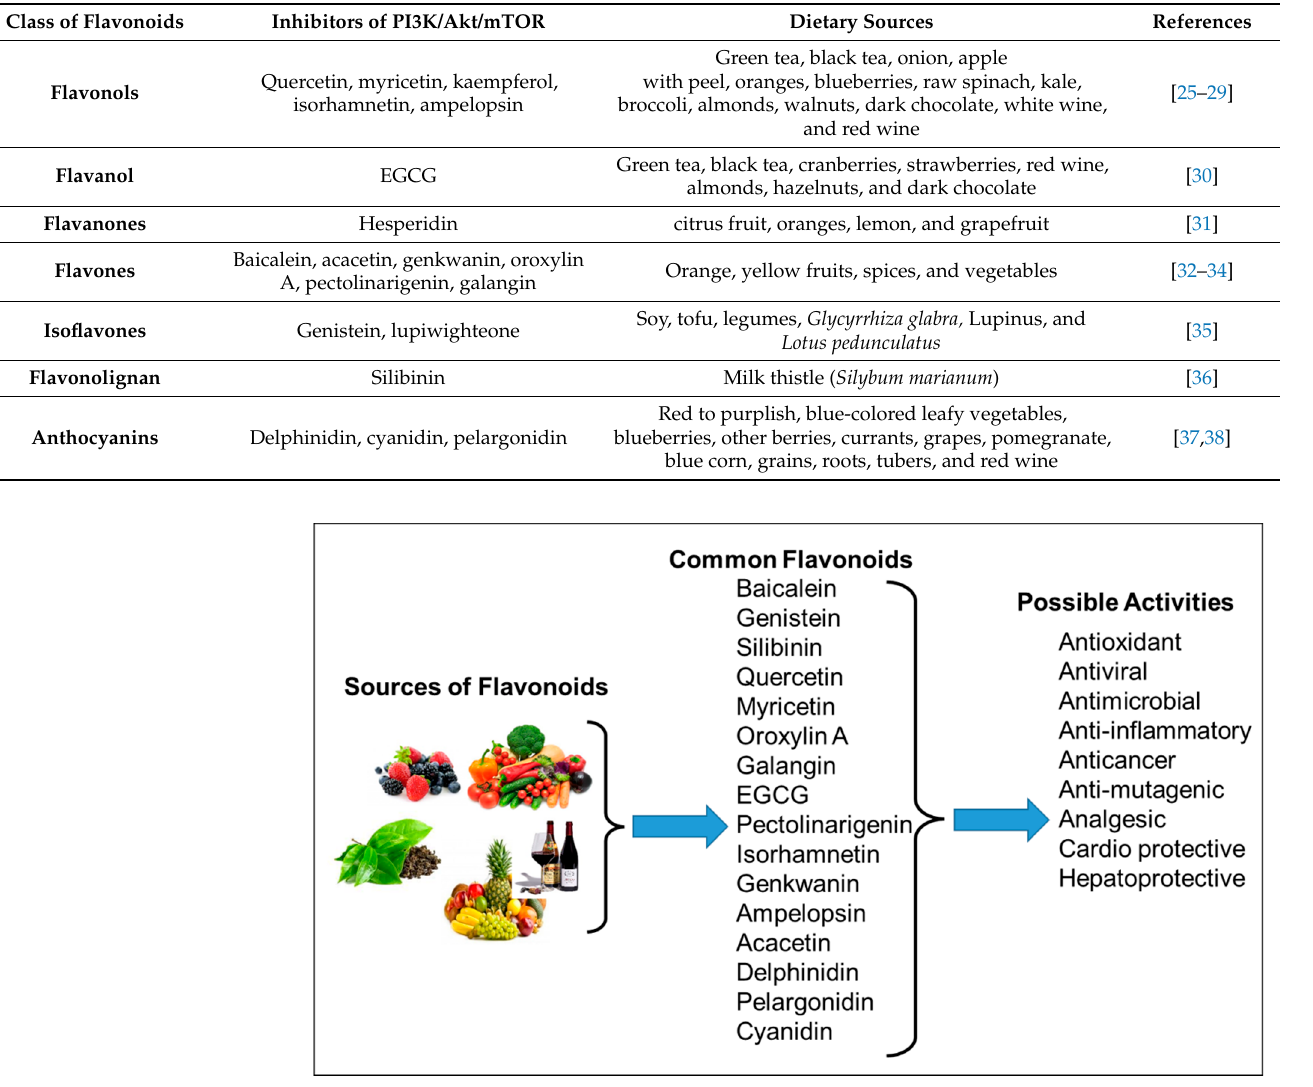
Figure 1. Common flavonoids from dietary sources, with their biological activities. EGCG; Epigallocatechin gallate. (Source: The effects of polyphenols and other bioactives on human health. https://pubs.rsc.org/image/article/2019/fo/c8fo01997e/c8fo01997e-f1_hi-res.gif accessed on 29 October 2021).